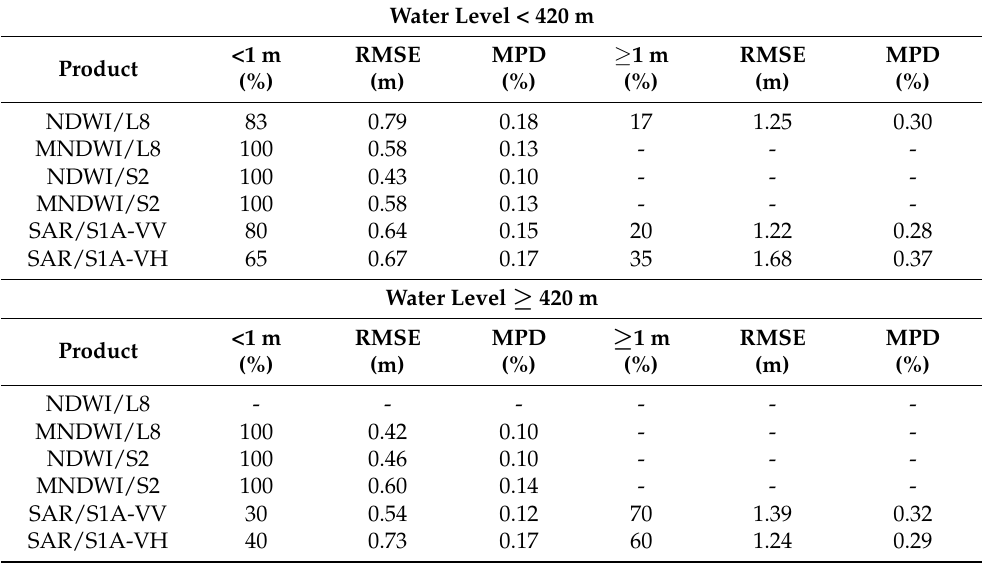
Table 8. Accuracy of water level